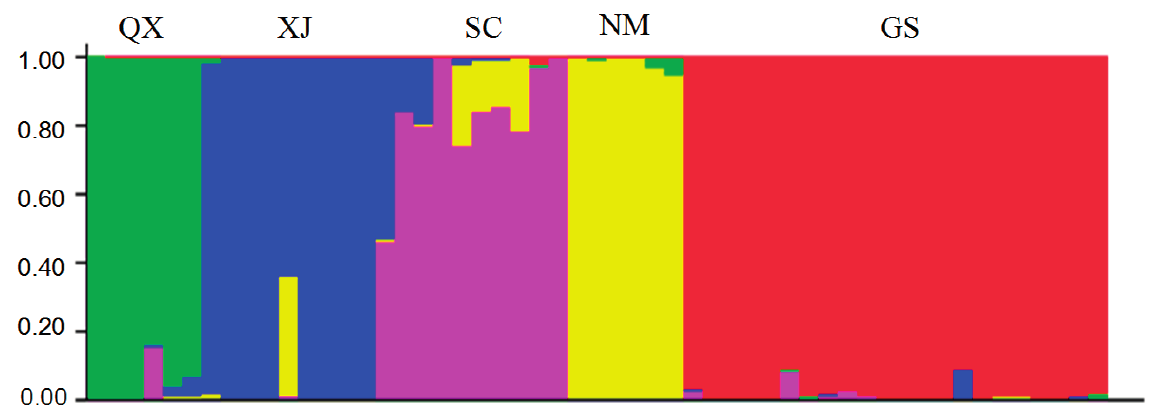
Figure 2. Five subgroups of 53 E. sibiricus accessions inferred from STRUCTURE analysis. The vertical coordinate of each subgroup indicates the membership coefficients for each accessions. Green zone: QX; Blue zone: XJ; Pink zone: SC; Yellow zone: NM; Red zone: